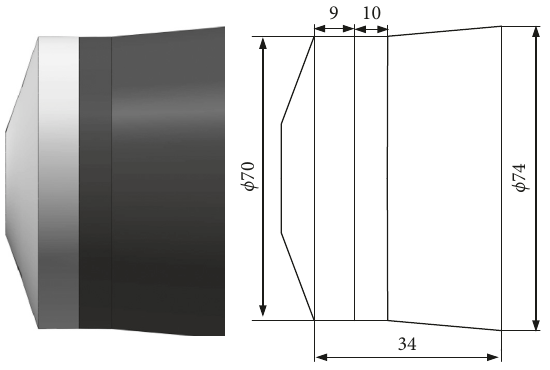
Figure 1: Standard piston and its dimensions (mm).